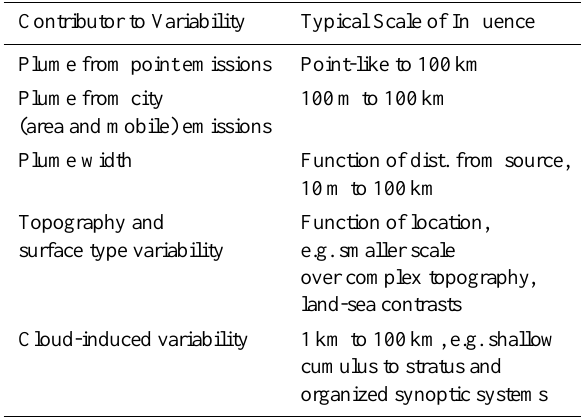
Table 1. Example influences on aerosol subgrid